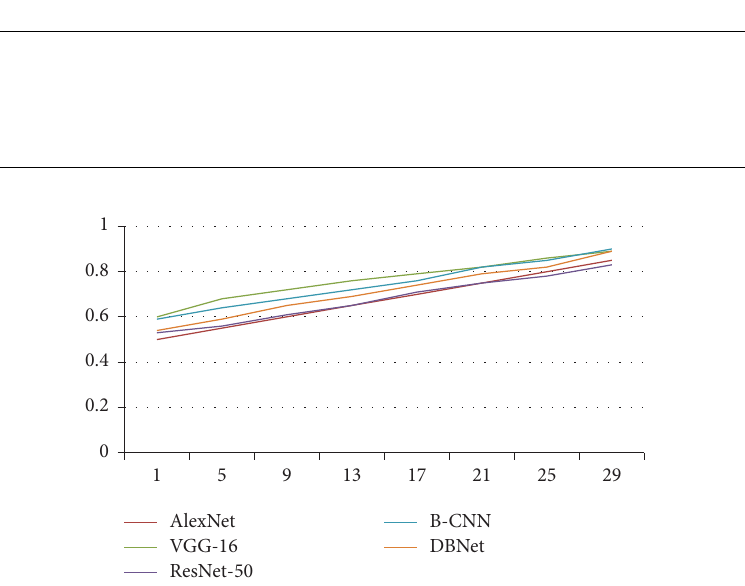
Figure 9: Comparison of accuracy changes of diferent network models. Table 9: Network